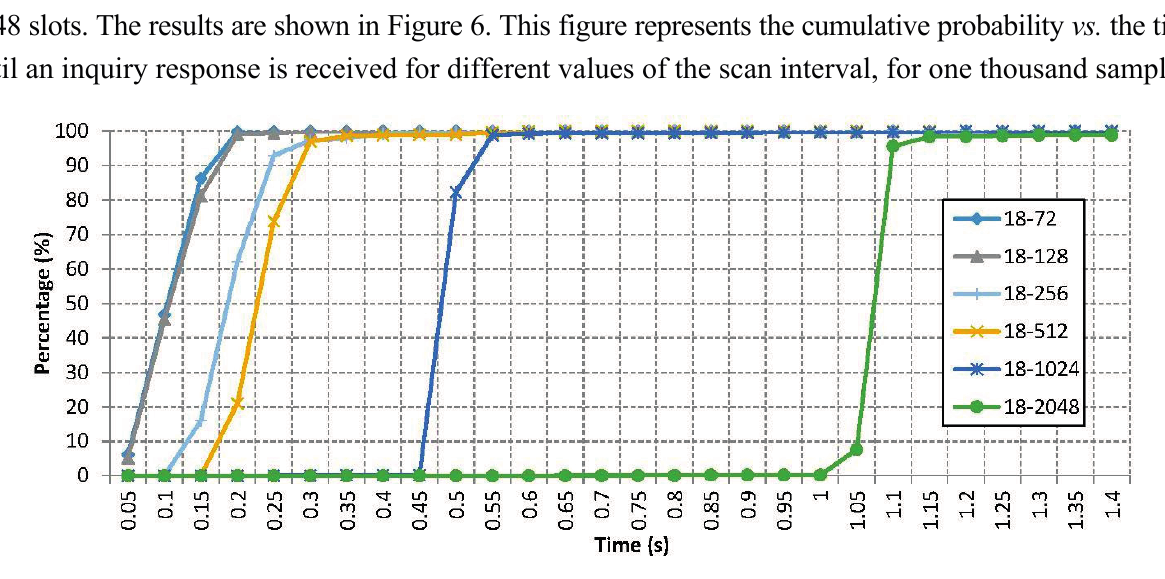
Figure 6. Cumulative probability for different values of the scan interval